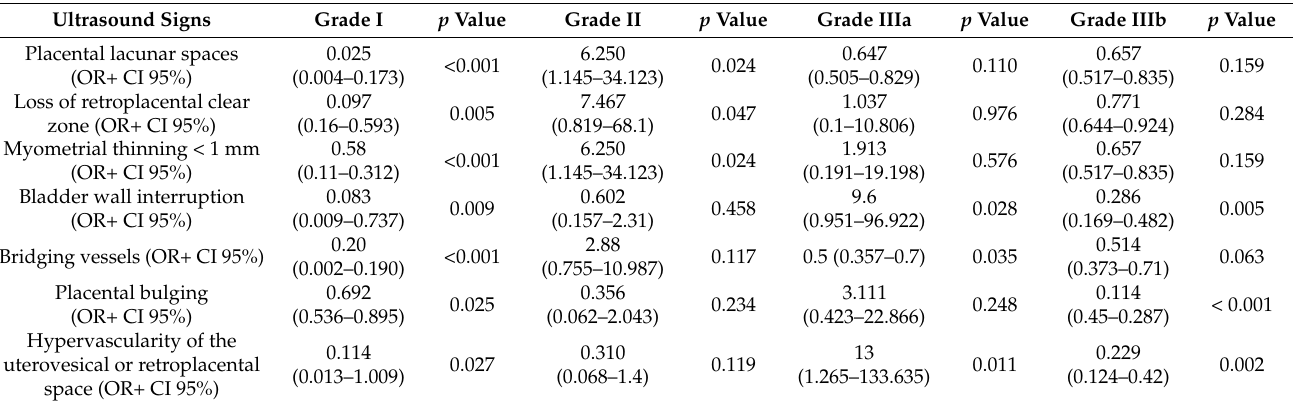
Table 4. Table 4. Multivariate logistic regression for the association between ultrasound signs and FIGO grading of PAS